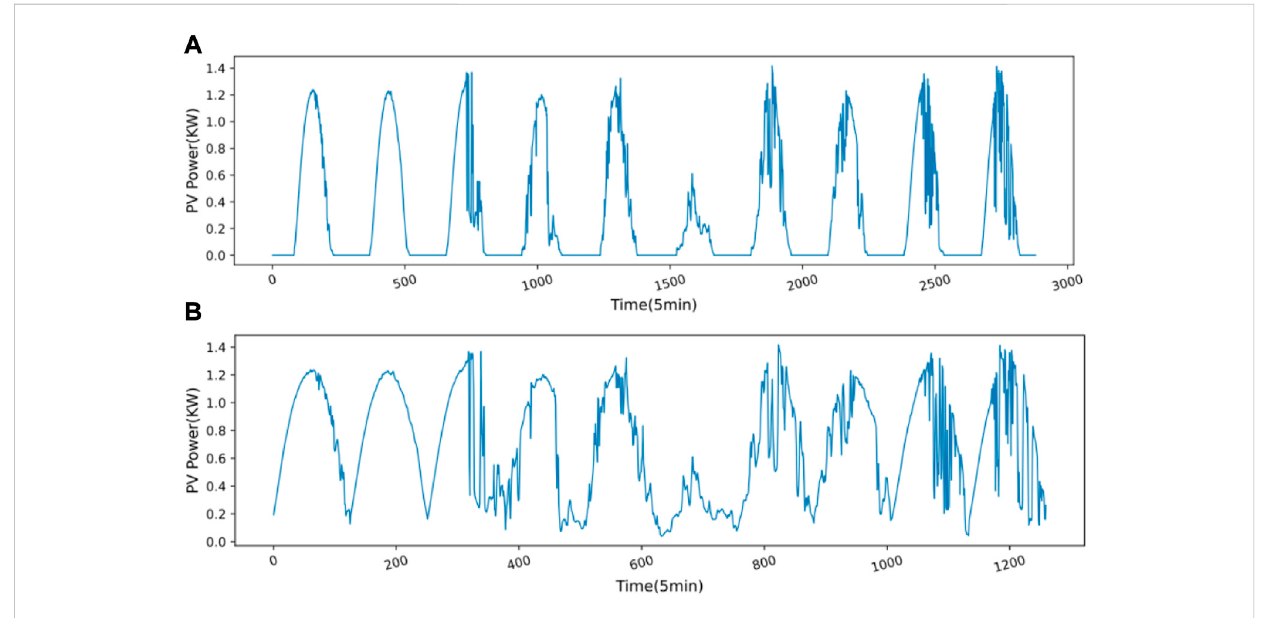
FIGURE 7 PV power data (A) before processing, (B) after processing.